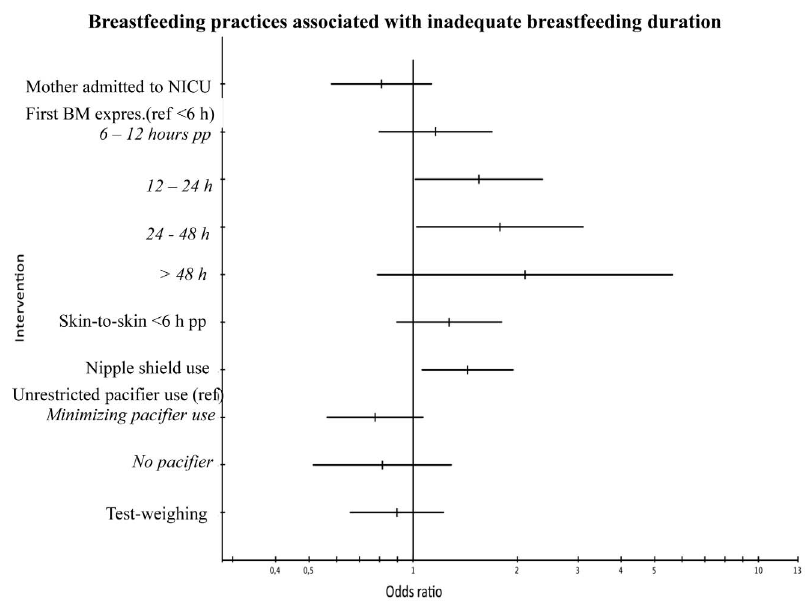
Figure 3. Forest plot. BM expres. = Breast milk expression, h = hours, NICU = Neonatal Intensive Care Unit, pp = postpartum, ref = reference.